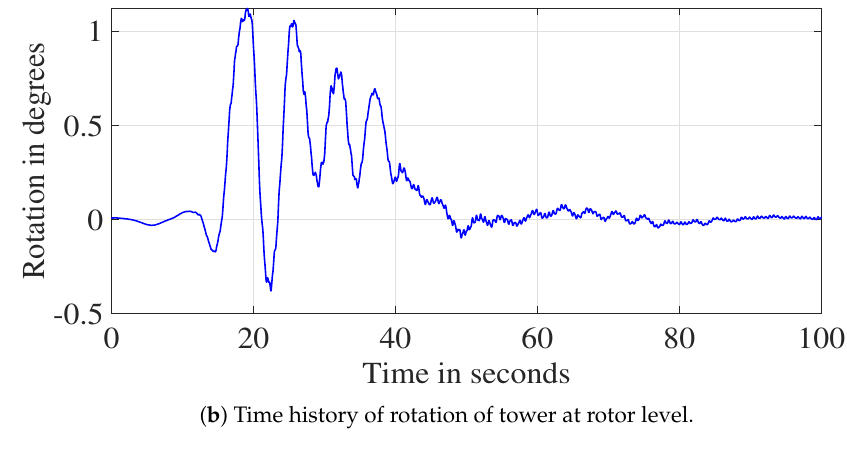
( b ) Time history of rotation of tower at rotor level.